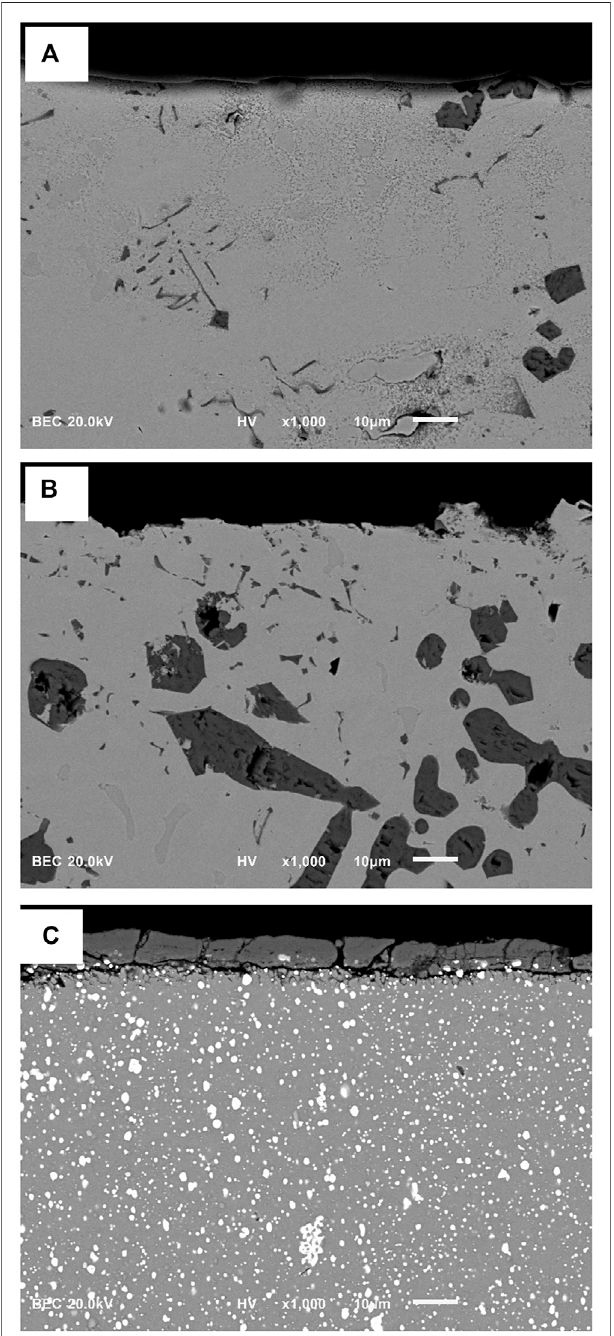
FIGURE10| Cross-sectionalmicrostructureofthesurfacewithoutworn at elevated temperature: (A) TC02 alloy, (B) TC05 alloy, and (C) M2 steel.